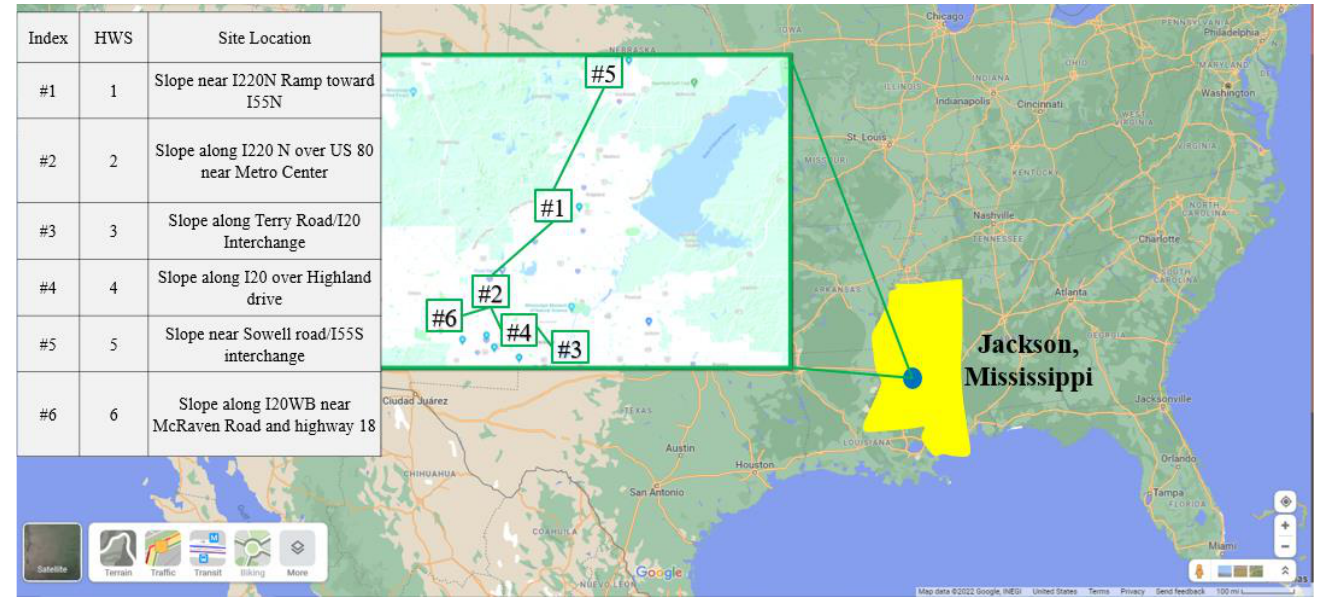
Figure 1. Site Locations of HWS.